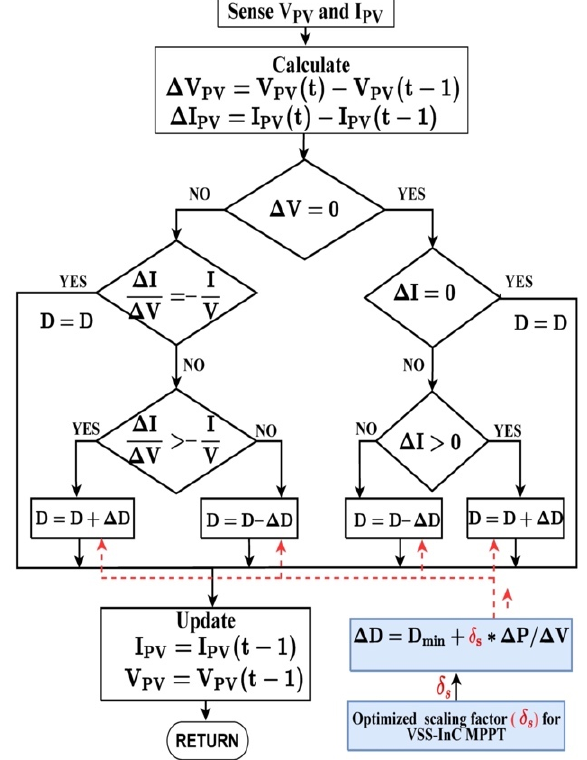
Figure 4. MOGHO algorithm based VSS-InC MPPT.